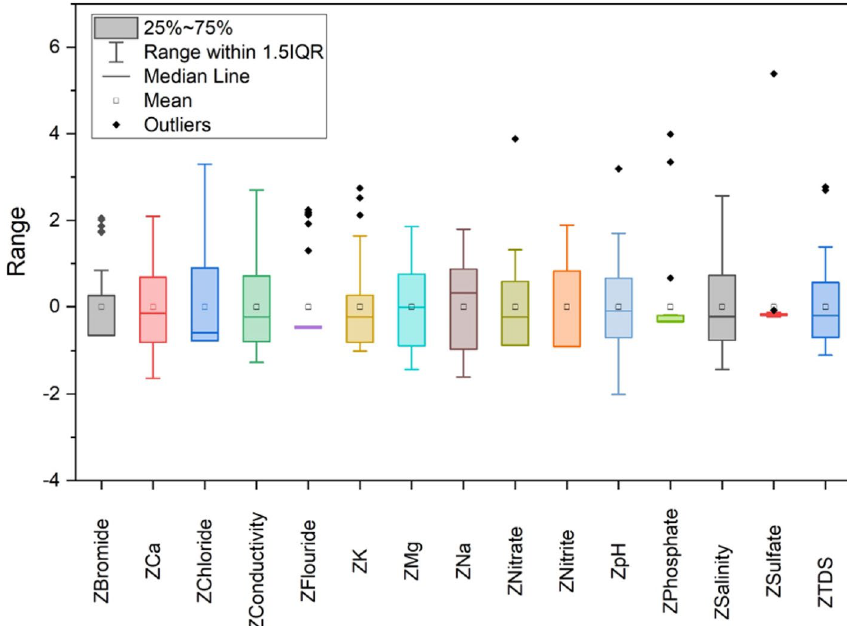
Figure 5. Box plot shows the z-score variability of data.